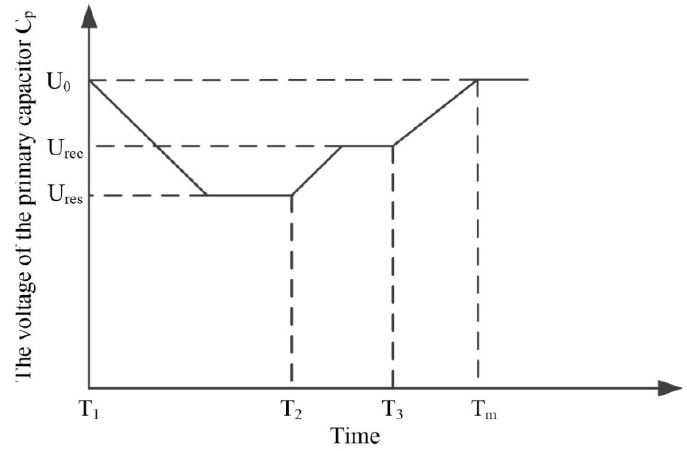
Figure 10. The sequence diagram of the thyristors.